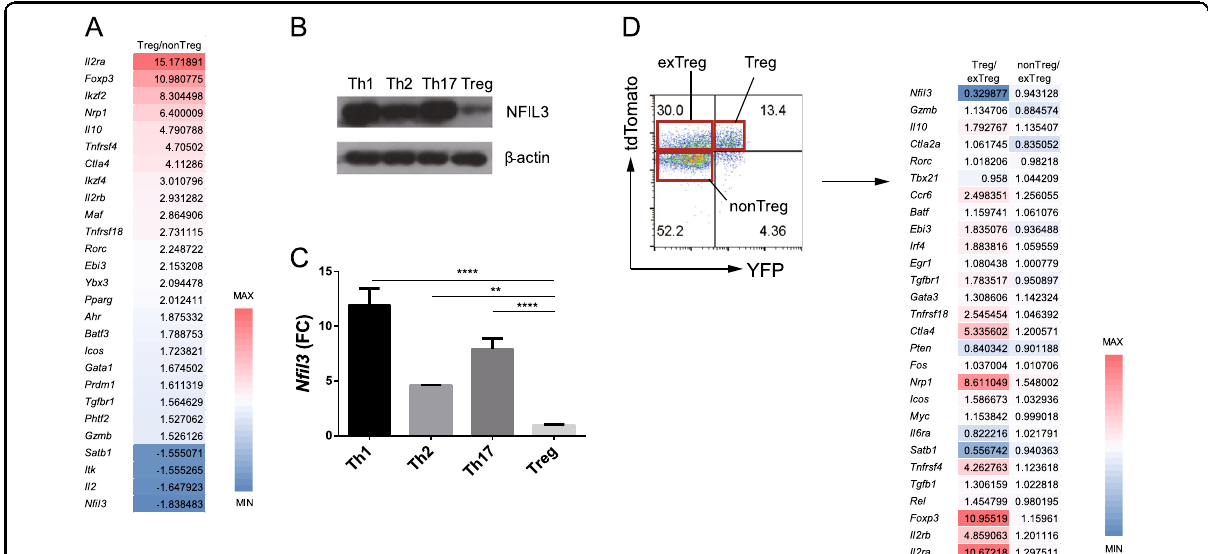
Fig. 1 N fi l3 expression in CD4 T-cell subsets. a Genes differentially expressed between Treg and non-Treg cells were analyzed by microarray analysis. Red represents increased, and blue represents decreased gene expression levels in Treg cells compared with non-Treg cells. Numbers indicate the fold-change in expression of each gene. b Western blot analysis of NFIL3 protein expression in each CD4 T-cell subset. Naive CD4 T cells were stimulated under Th1, Th2, Th17, and Treg-polarizing conditions for 3 days. β -Actin was used as a control. c N fi l3 mRNA expression in each subset was measured by qRT-PCR. Data are representative of three independent experiments. d Flow cytometry analysis of splenocytes from Foxp3 CRE/YFP X Rosa26 tdTomato mice (left). Treg (#1), ex-Treg (#2), and non-Treg (#3) cells were sorted as shown. Microarray analysis data showing selected gene expression levels in each group (right). Numbers indicate the fold-change in expression of each gene. Error bars represent the standard deviation (SD). The signi fi cance of differences between groups was determined by two-way ANOVA; * P < 0.05, ** P < 0.01, *** P < 0.001, and **** P < 0.0001, n.s. not signi fi